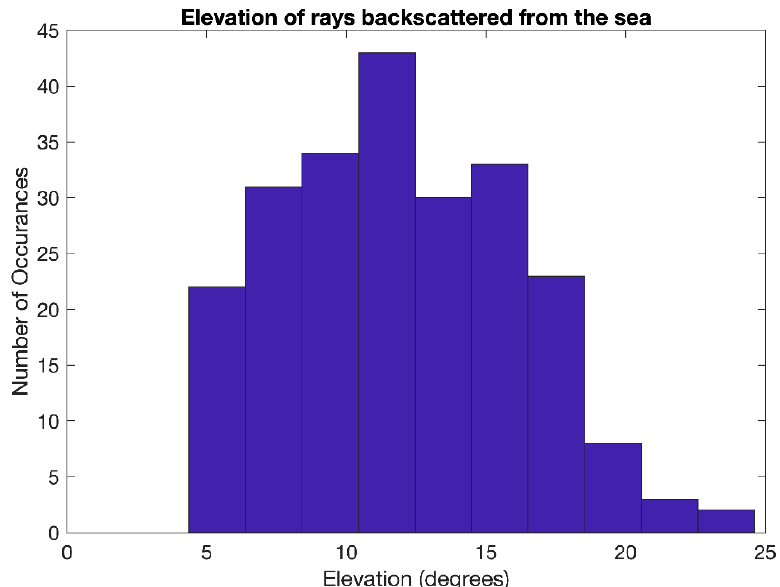
Figure 12. Histogram of the mean elevation of the rays reaching each range-azimuth cell for Alice Springs and Longreach in September 2015 and March 2016. The mean value is 12 degrees.